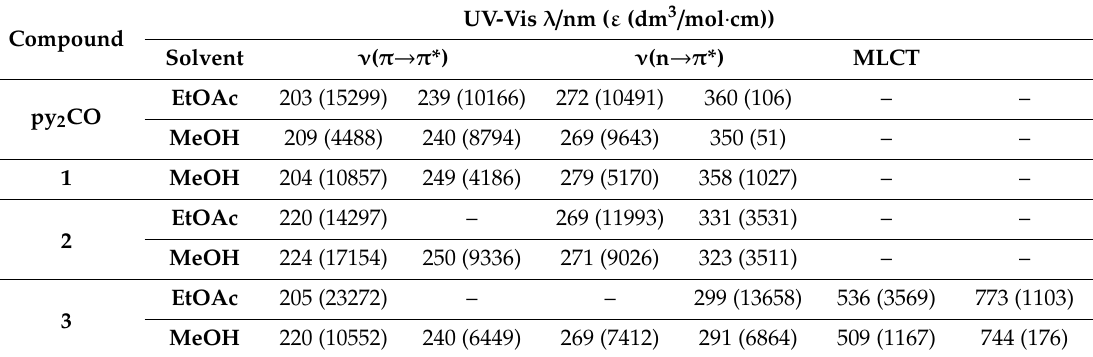
Table 5. Summary of electronic spectral data of 1 – 3 complexes and free ligand.